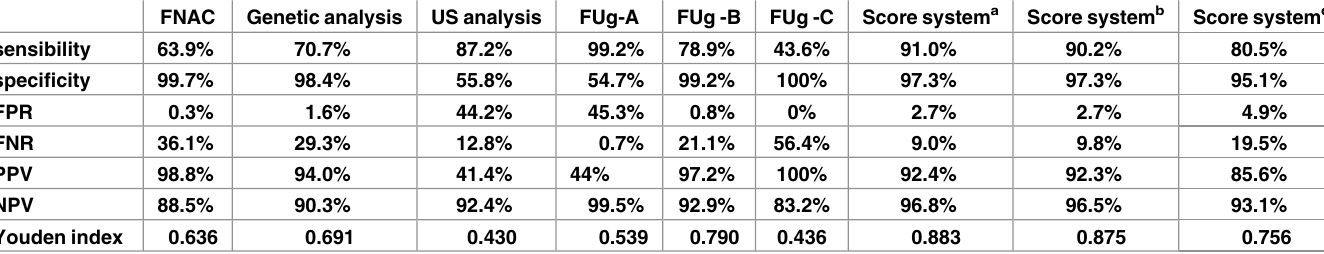
Table 5. Application of FNAC, US, Genetic analysis and score system in thyroid cancers.